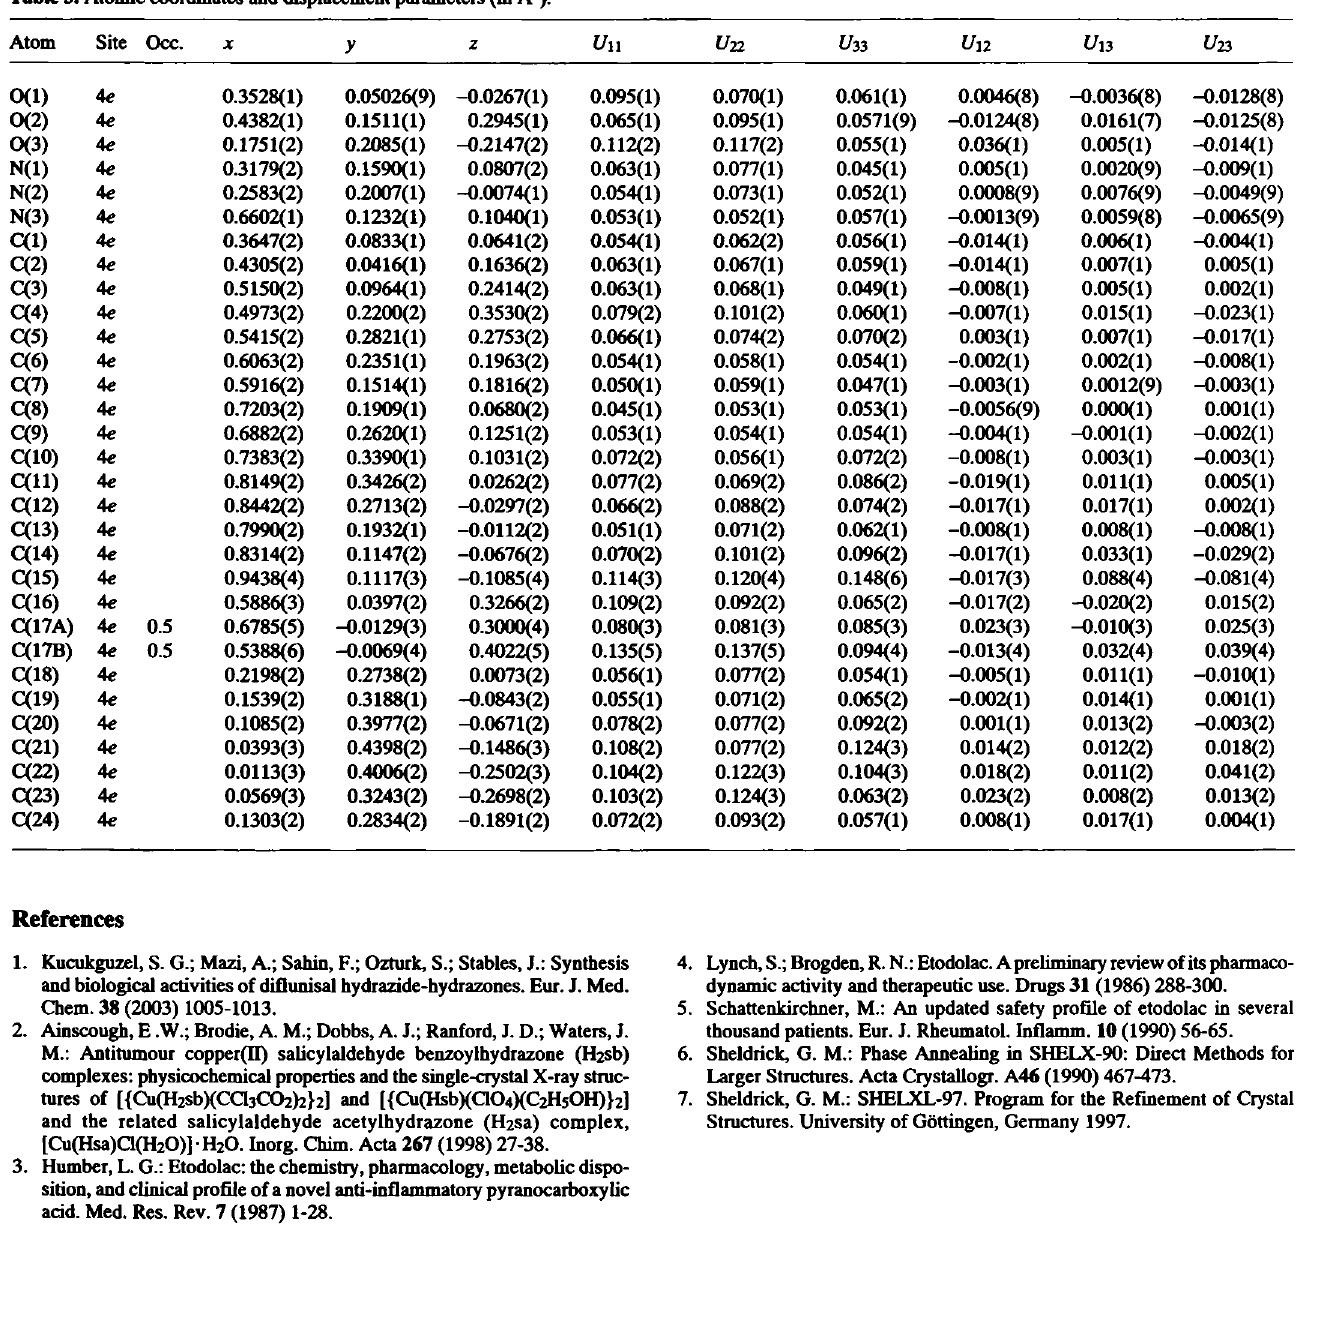
Table 3. Atomic coordinates and displacement parameters (in Ä 2